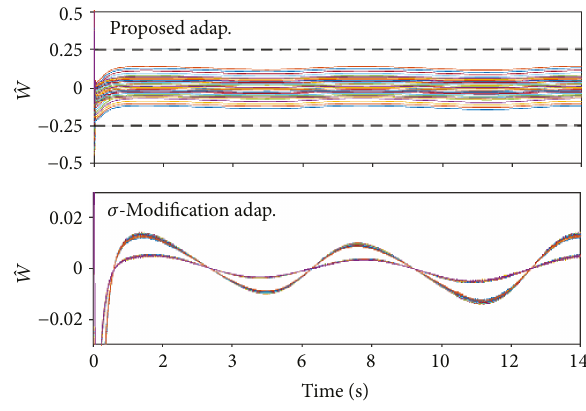
Figure 7: The online obtained weight of